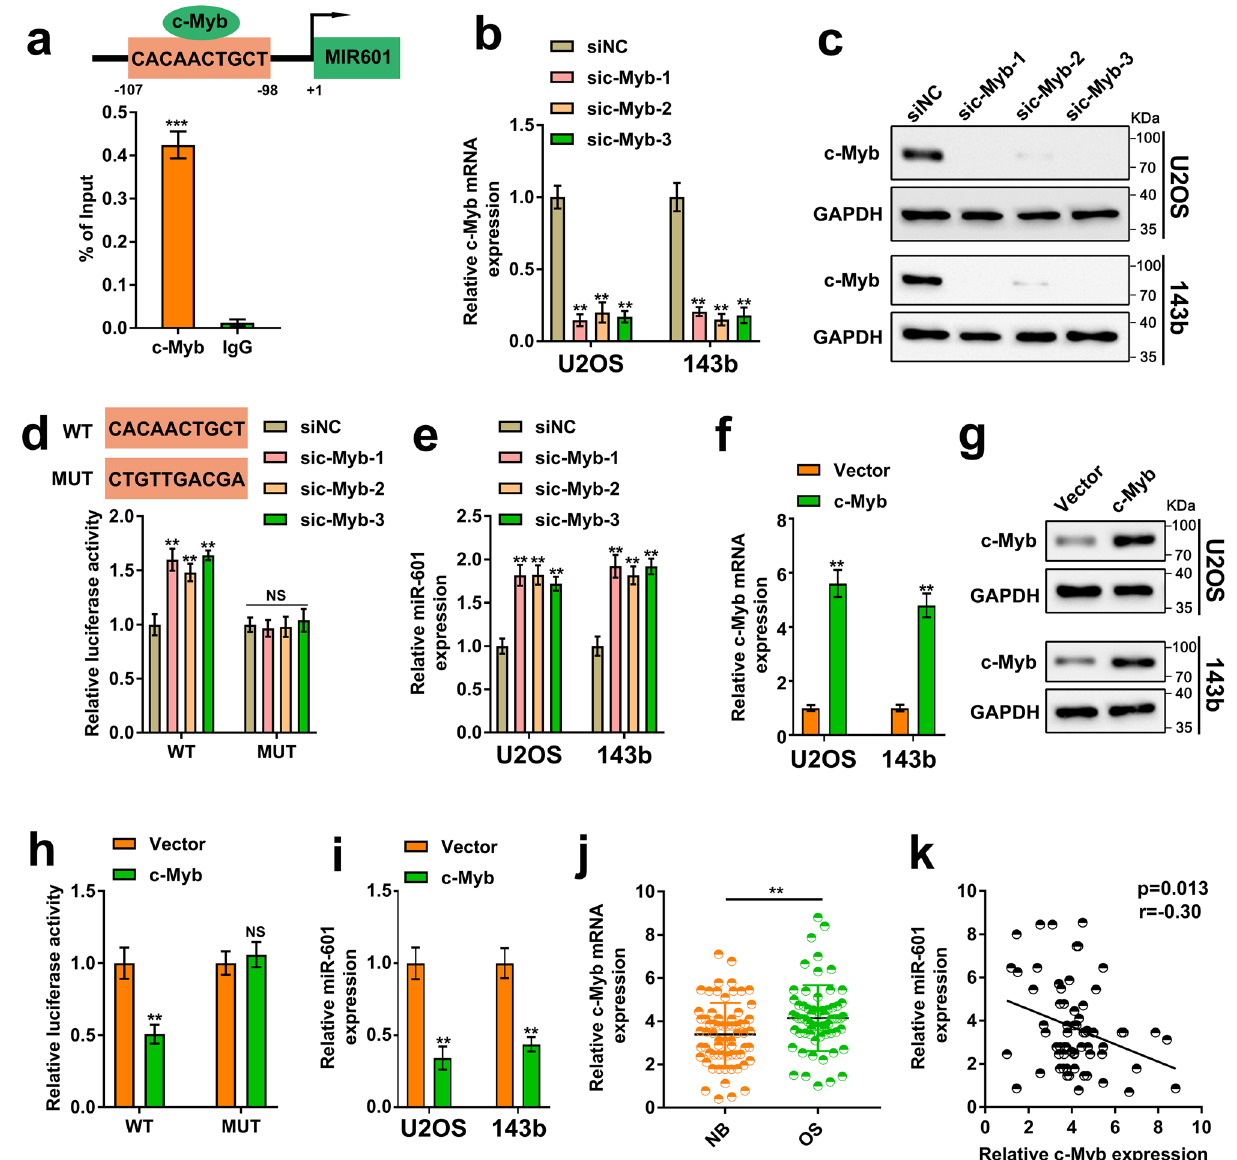
Figure 5. c-Myb is involved in the downregulation of miR-601 in OS cells. ( a ) (Up) Schematic diagram displayed the putative c-Myb binding sites on the promoter of MIR601. (Down) Chip assay was performed using anti-c-Myb or anti-IgG antibodies. ( b, c ) The knockdown efficiency of c-Myb was evaluated by RT-qPCR assay and Western blot assay. The original blots/gels are presented in Supplementary Dataset File. ( d ) (Up) Schematic diagram displayed the wild type and mutant type of putative binding sites of c-Myb on the promoter of MIR601. (Down) The luciferase activity of c-Myb knockdown U2OS and 143b cells, co-transfected with luciferase reporter plasmid coding MIR601 promoter sequence or scrambled vector, was accessed by luciferase reporter assay. ( e ) The miR-601 expression was evaluated by RT-qPCR assay in U2OS and 143b cells with c-Myb knockdown. ( f, g ) The level of c-Myb mRNA and protein were detected via RT-qPCR and Western blot assay in c-Myb overexpression U2OS and 143b cells. The original blots/gels are presented in Supplementary Dataset File. ( h ) The luciferase activity of c-Myb overexpression U2OS and 143b cells, co-transfected with luciferase reporter plasmid coding MIR601 promoter sequence or scrambled vector, was accessed by luciferase reporter assay. ( i ) The miR-601 expression was evaluated by RT-qPCR assay in U2OS and 143b cells. ( j ) The mRNA level of c-Myb were measured via RT-qPCR assay in 66 paired OS tissues and normal tissues. ( k ) Pearson correlation analysis displayed the correlation between miR-601 and c-Myb in OS